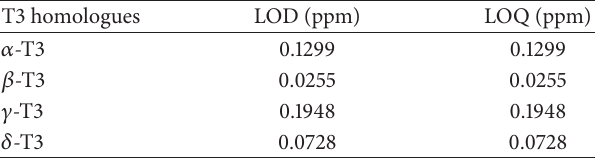
Table 2: LOD and LOQ of T3 homologues.